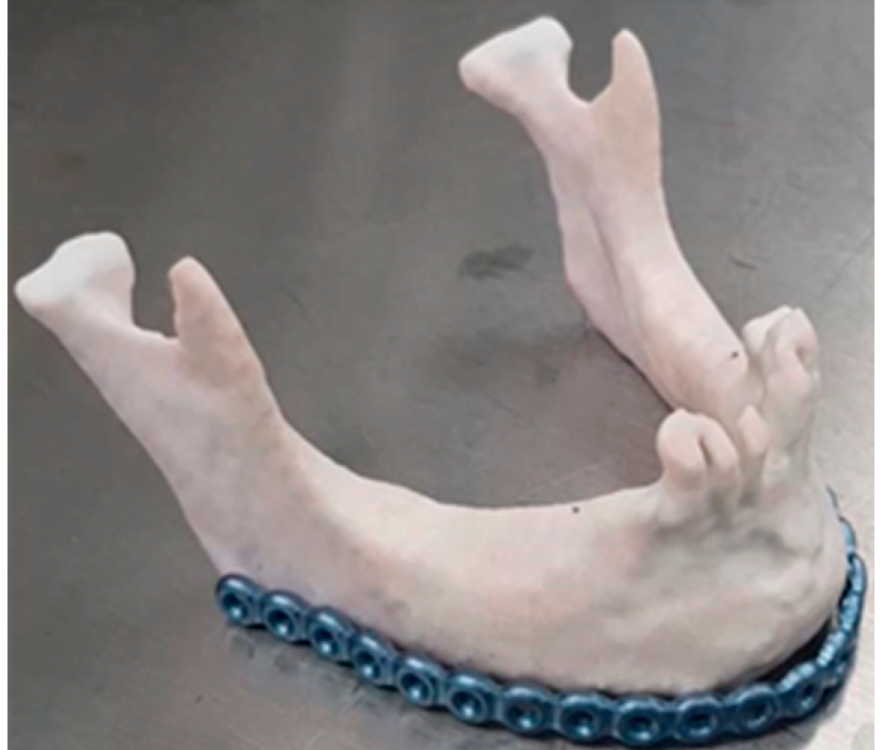
Figure 4. Implants pre-bending on 3D-printed models. Pre-bending of a reconstruction plate for mandibular reconstruction prior to the resection of the symphysial region due to SCC invasion.